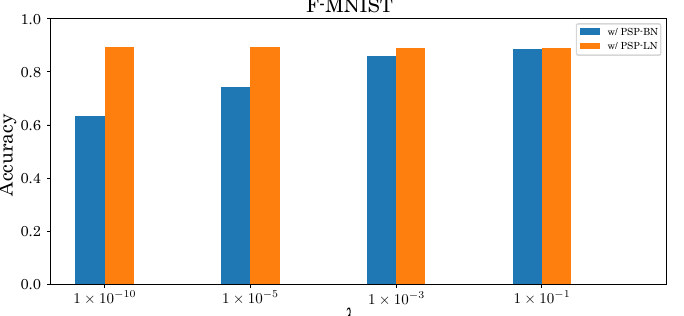
Figure 12. Accuracy comparison of F-MNIST with respect to changing λ ( =